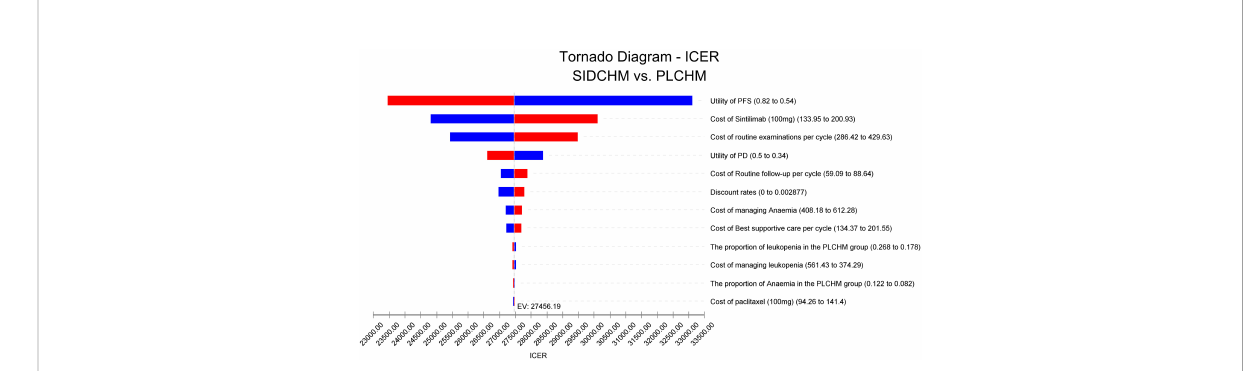
FIGURE 2 One-way sensitivity analyses of SIDCHM in comparison with PLCHM in China. BSA, body surface area; PD, progressive disease; PFS, progression-free survival; PLCHM, placebo plus chemotherapy; SIDCHM, sintilimab plus